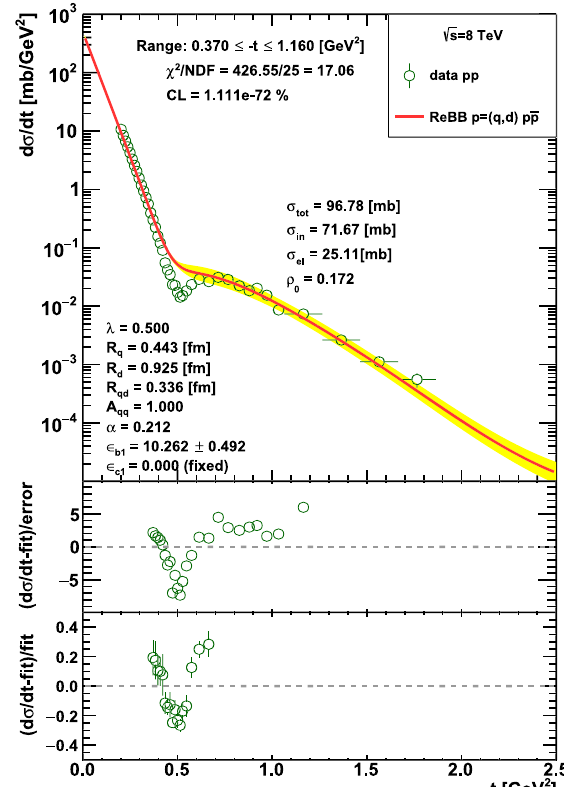
Fig. 2 Comparisonofthe p ¯ p differentialcrosssectioncalculatedfrom the ReBB model—using the energy calibration of the fit parameters done in Ref. [1]—with the 8 TeV pp differential cross section data measured by TOTEM [15]. Same as Fig. 1, but now the p ¯ p prediction of the ReBB model with its systematic error band. The Odderon signal corresponds to the statistical difference between the yellow error-band, valid for p ¯ p ReBB model extrapolated data, and the TOTEM measure- √ s = 8 TeV. On this figure, the shown values refer ments of pp data at to p ¯ p elastic scattering, corresponding to the model predictions for p ¯ p physical observables at t = 0 and the ReBB model parameter values for p ¯ p obtained from previously determined trends